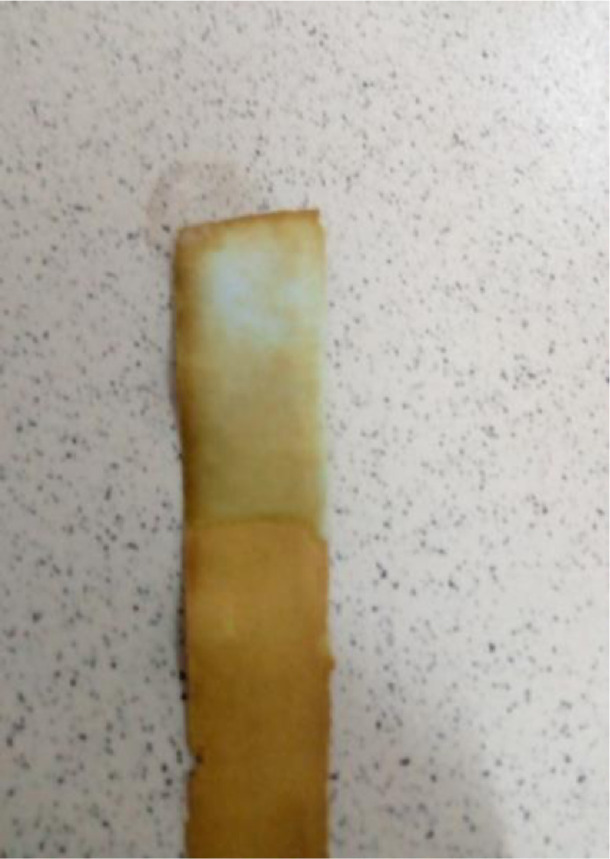
Soaked litmus paper.